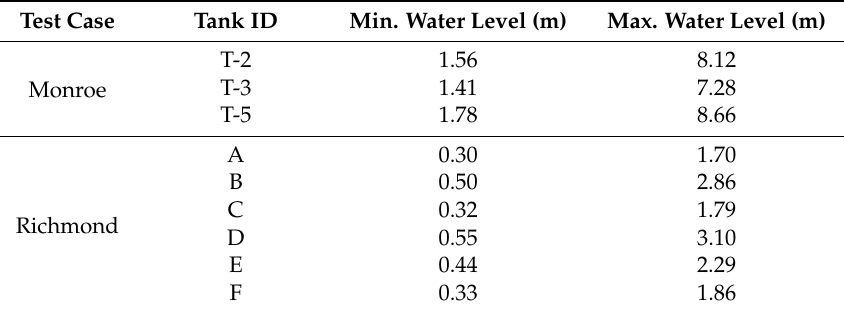
Table 3. Water level constraints for tanks of Monroe and Richmond WDS